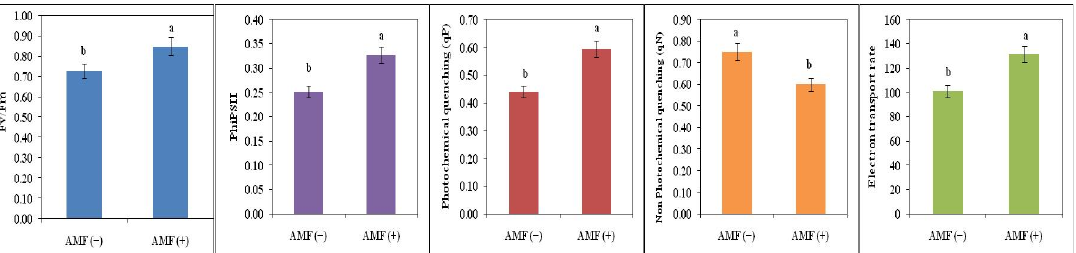
Figure 4. Maximum PSII efficiency (Fv/Fm), PhiPSII, photochemical quenching, non ‐ photochemical quenching, electron transport rate of non ‐ inoculated AMF ( − ) and inoculated plants AMF (+) of soybean. The vertical bar indicates ± SE for the mean. The means for each main treatment followed by the different letters are significantly different ( p ≤ 0.05).